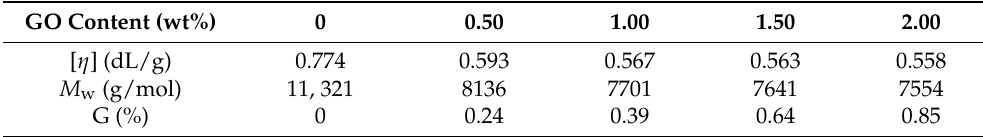
Figure 6. A schematic description of the crosslinking mechanism of GO. ( a ) GO contains oxygenic groups such as hydroxyls that may undergo homolytic cleavage at high temperature ; ( b ) Sche- matic diagram of crosslinking of graphene oxide surface Table 2. Gel content and intrinsic viscosity data of SPA samples . GO Content (wt%)